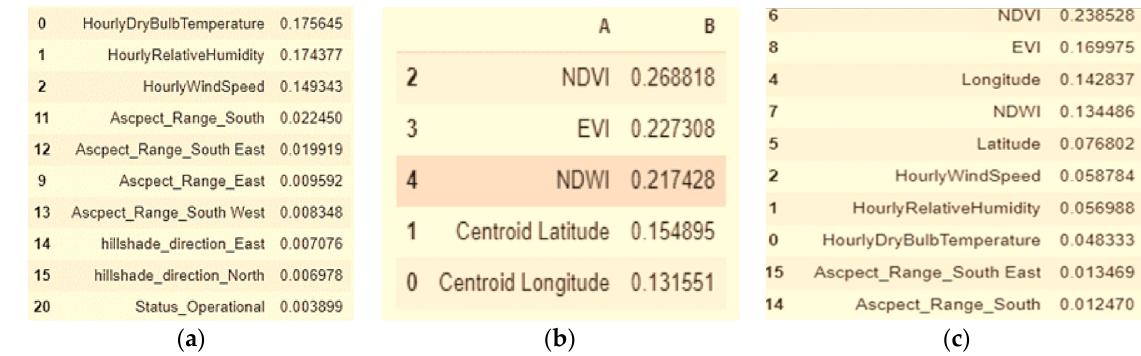
Figure 4. Feature importance for weather, powerline, and terrain dataset ( a ), vegetation dataset ( b ), and combined dataset ( c ).